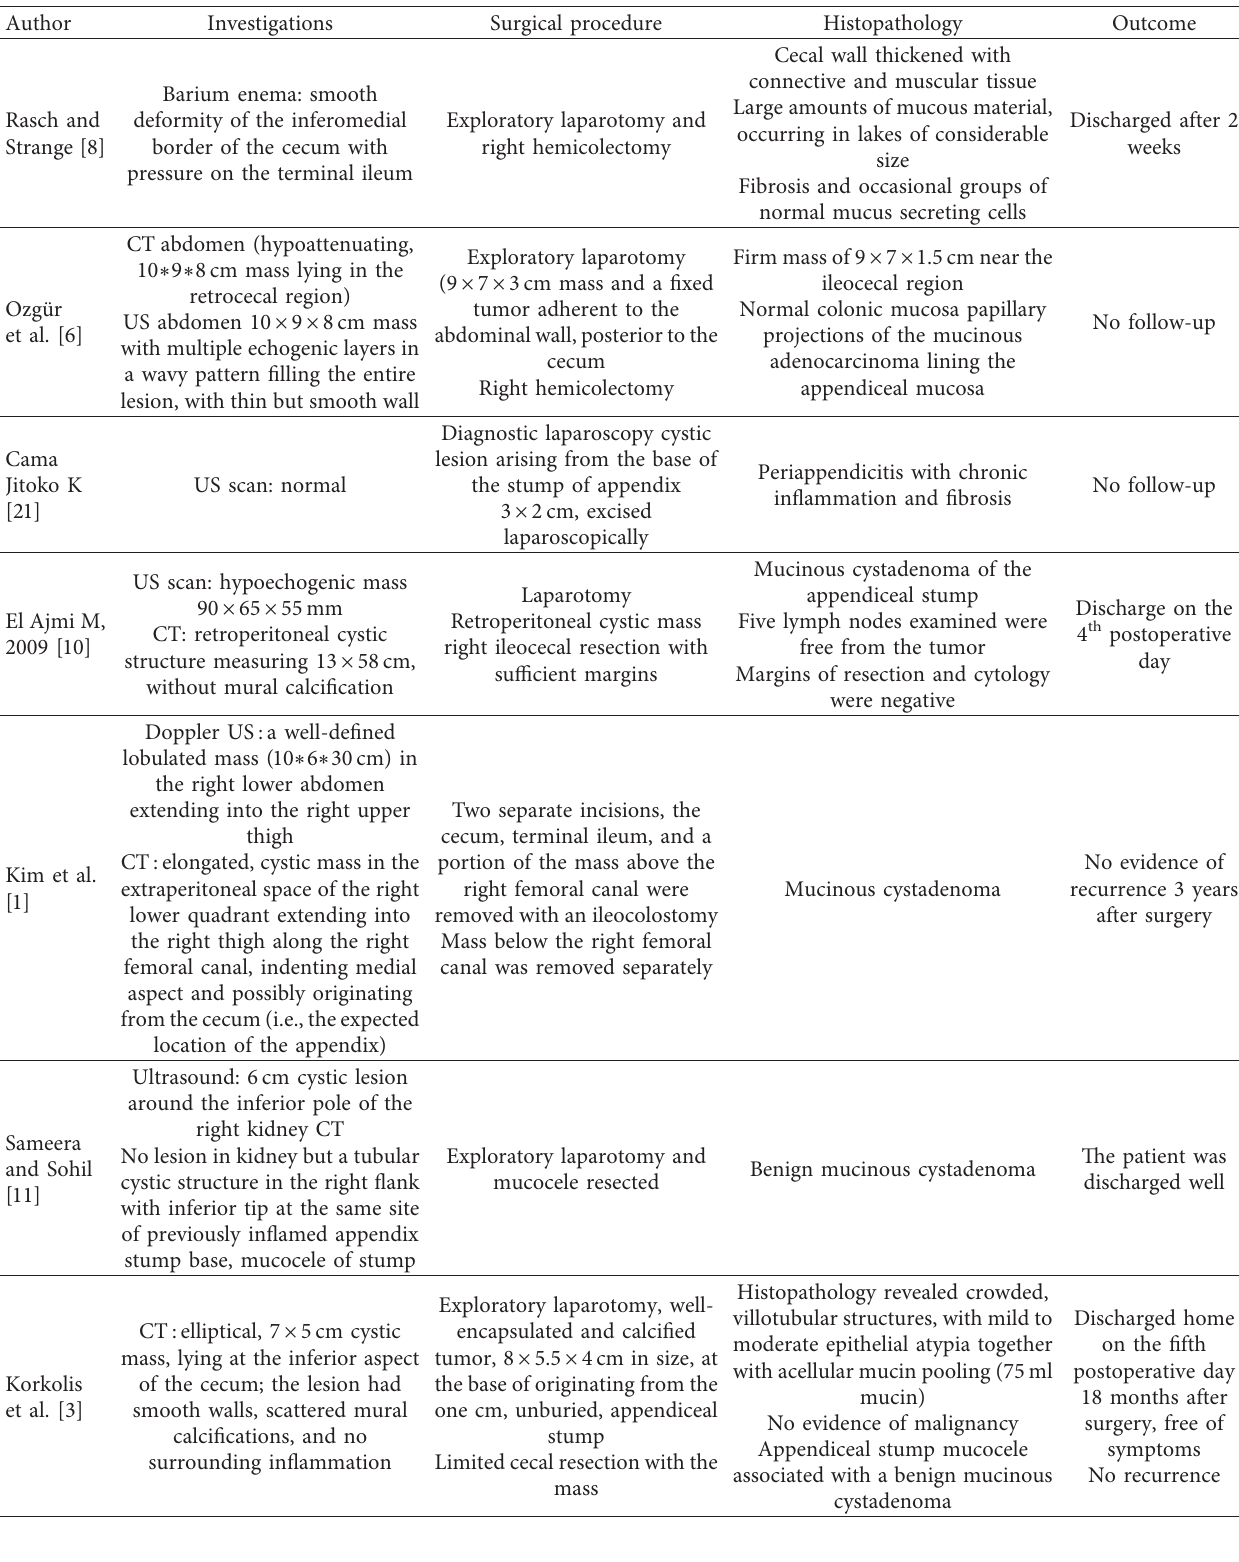
Table 2: Investigations, surgical procedure, histopathology, and